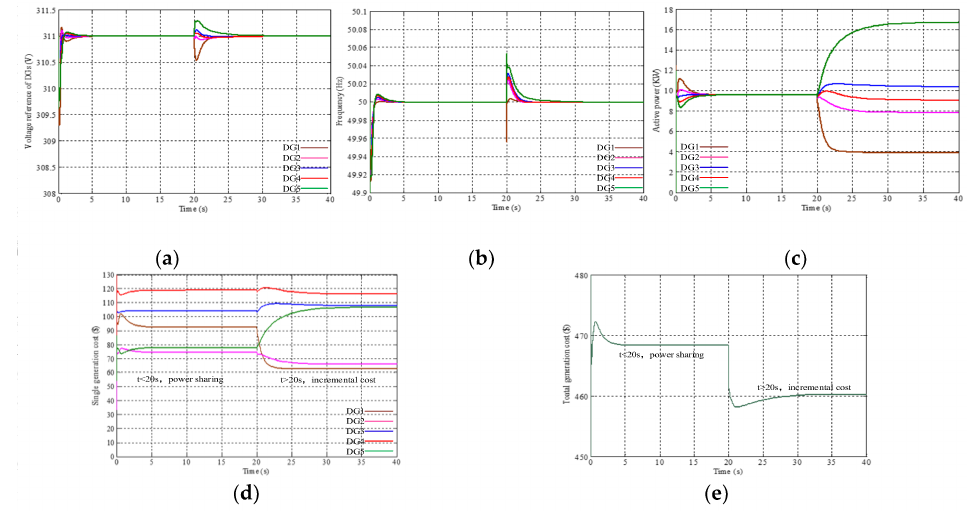
Figure 8. Total generation cost under different control strategies. ( a ) Voltage reference of DGs. ( b ) Frequency of DGs. ( c ) Active power of DGs. ( d ) Single generation cost. ( e ) Total generation